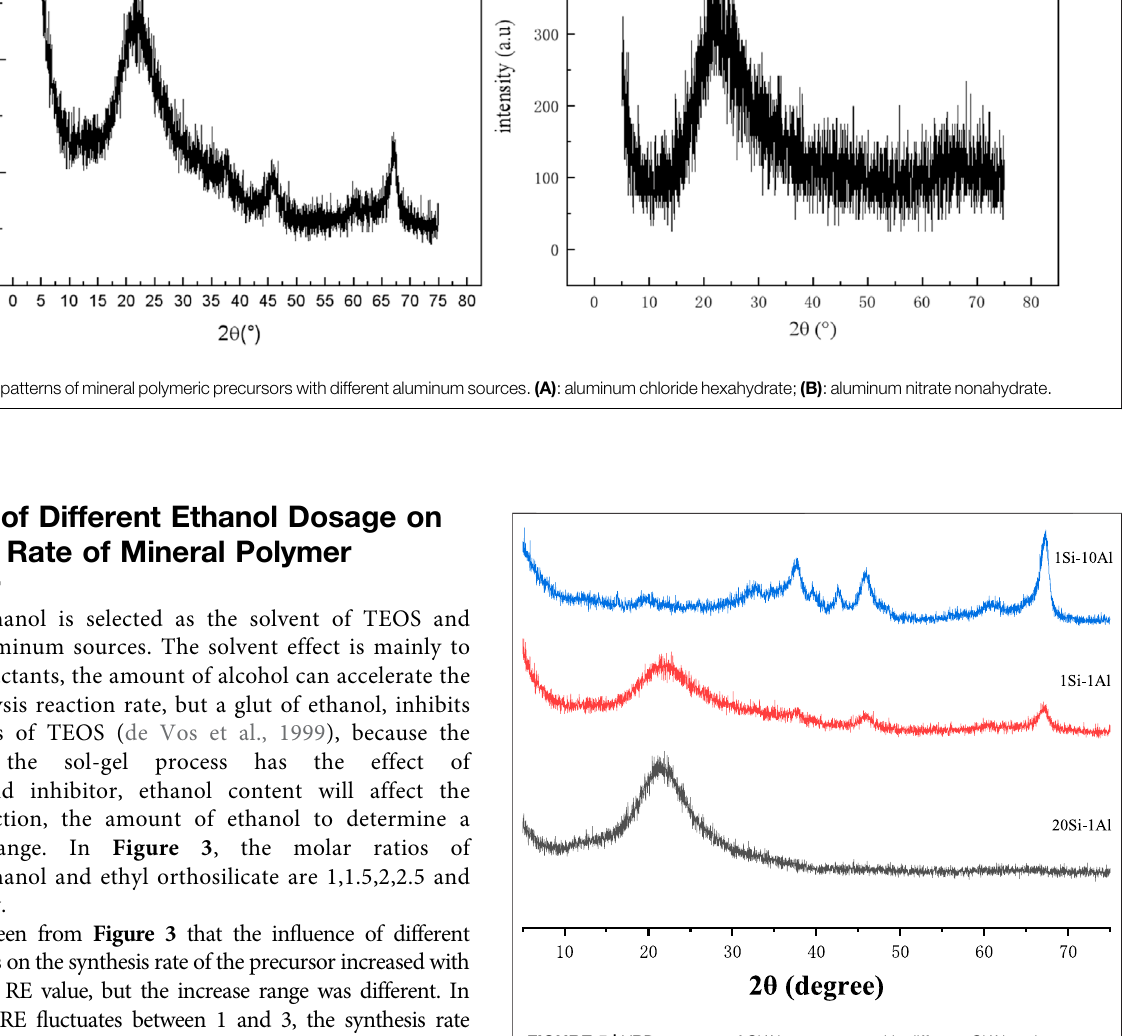
FIGURE 5 | XRD patterns of Si/Al precursors with different Si/Al molar ratios after heat treatment at 850 °